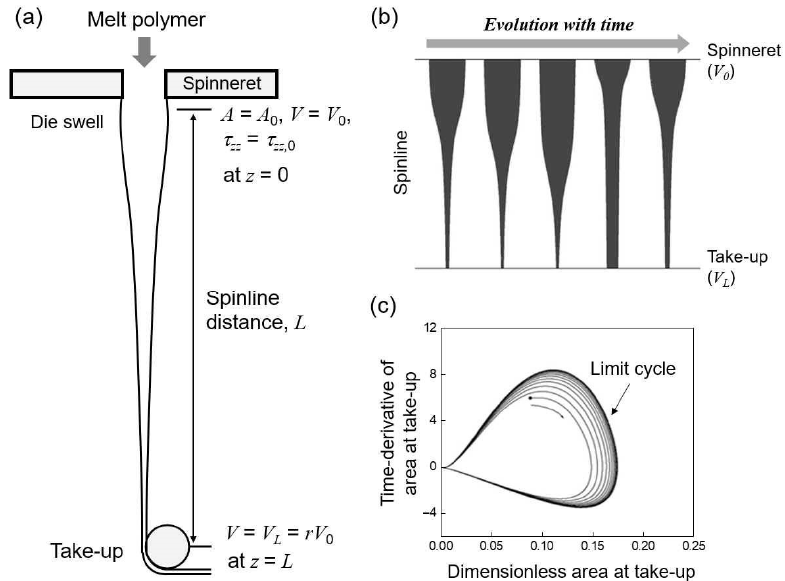
Figure 1. Schematics of ( a ) melt spinning process with spinline conditions, ( b ) periodic oscillation of filament during draw resonance, ( c ) limit cycle of spinline area at take-up position over the critical drawdown ratio.